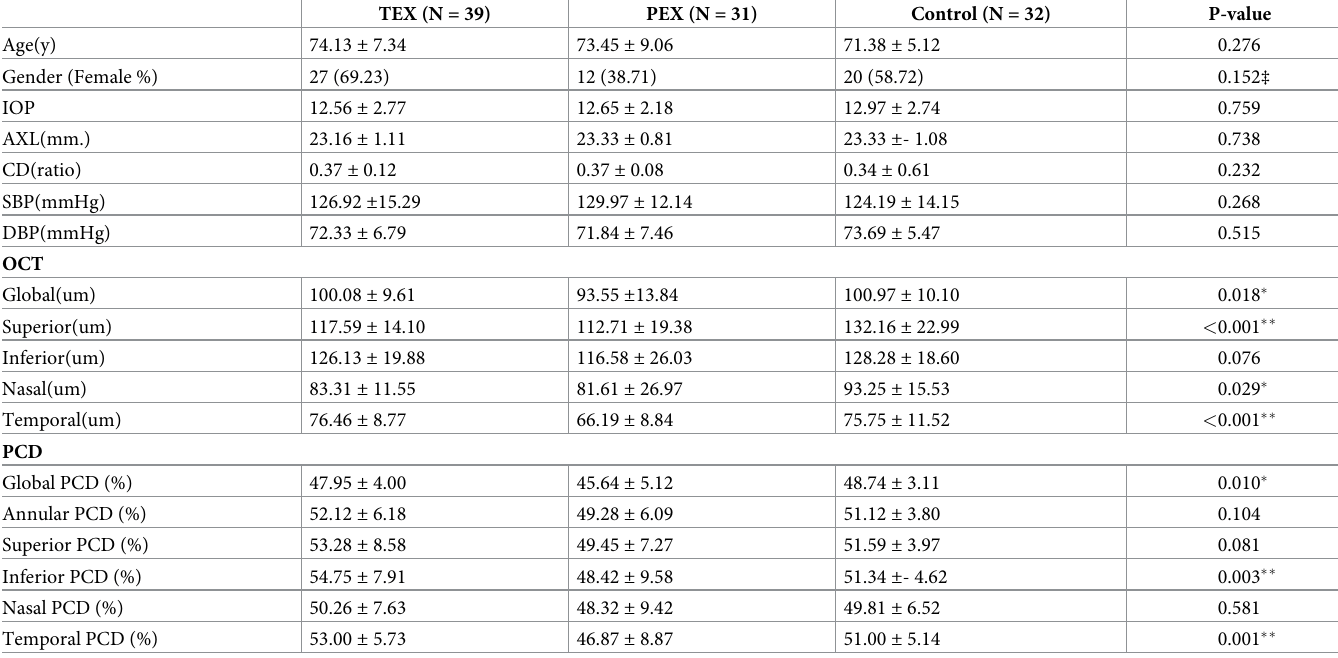
Table 1. Clinical and demographic data of TEX, PEX and control